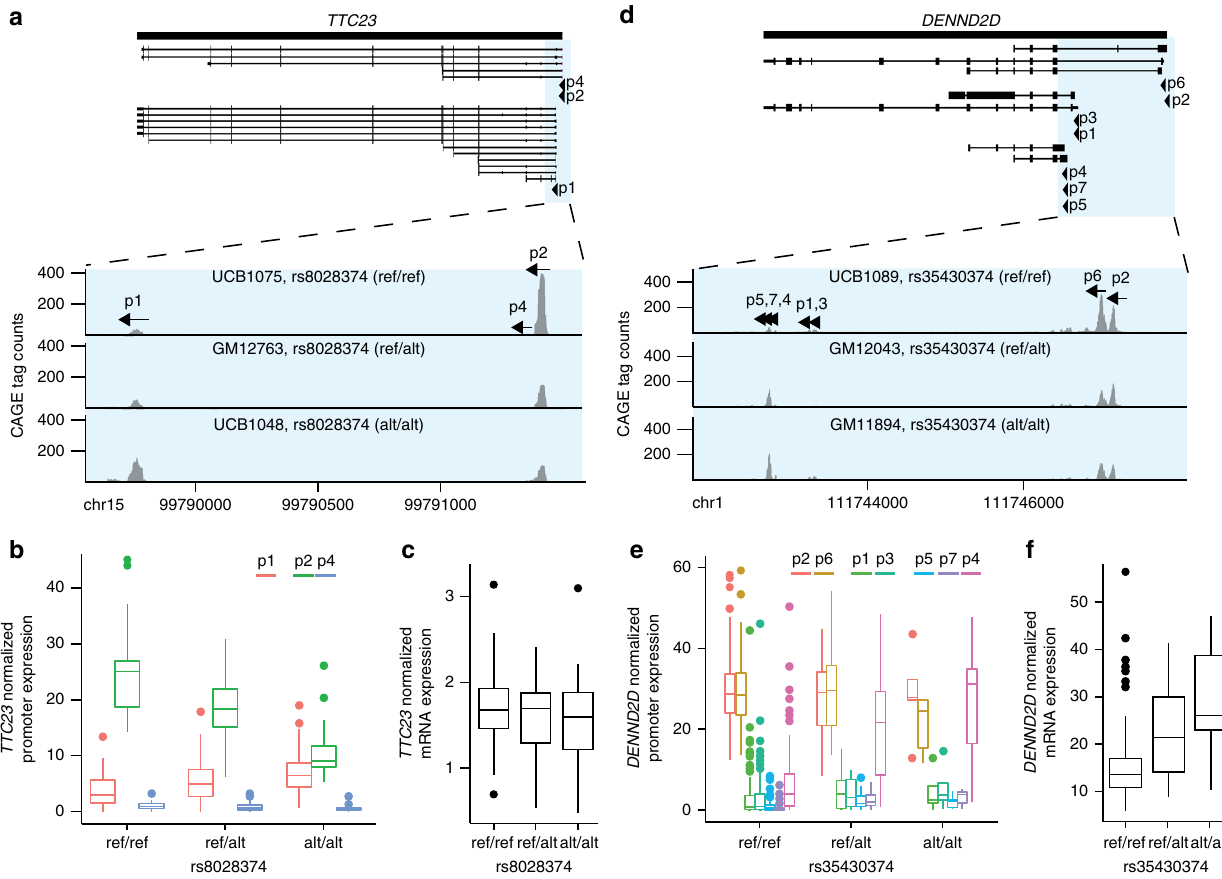
Fig. 3 Implication of differential promoter usage on mRNA level. Transcript isoforms and row CAGE tag distribution of promoter regions are plotted for individuals of each genotype group for puQTLs associated for the TTC23 ( a – c ) and DENND2D ( d – f ) genes. Normalized promoter ( b , e ) and mRNA ( c , f ) expression relative to each genotype group are plotted for the entire population ( n =